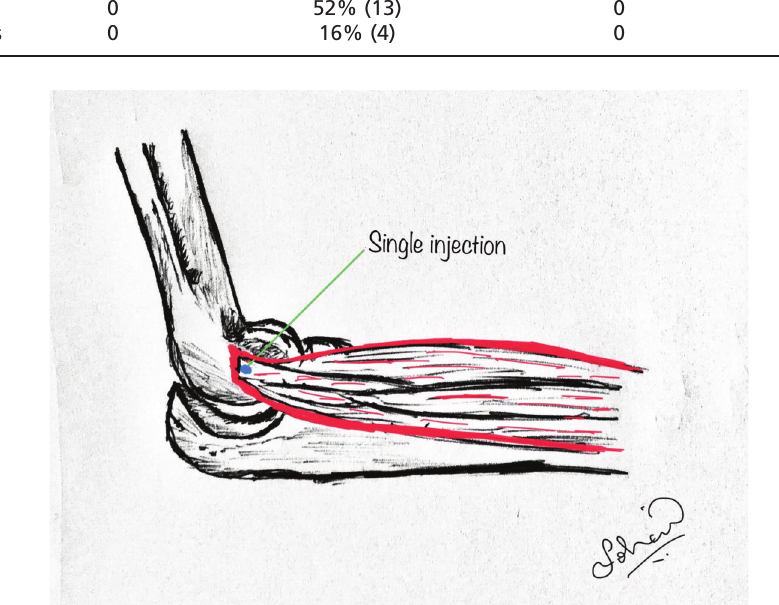
Single injection technique. Fig. 1: